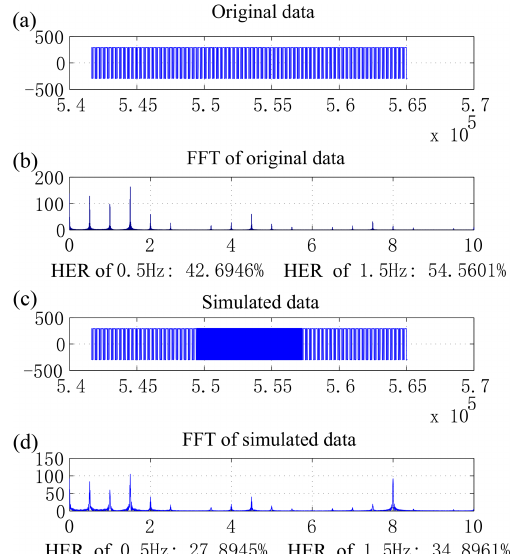
Figure 12. Original data (a, b) and simulated data of harmonic- energy-ratio variation (c, d) .